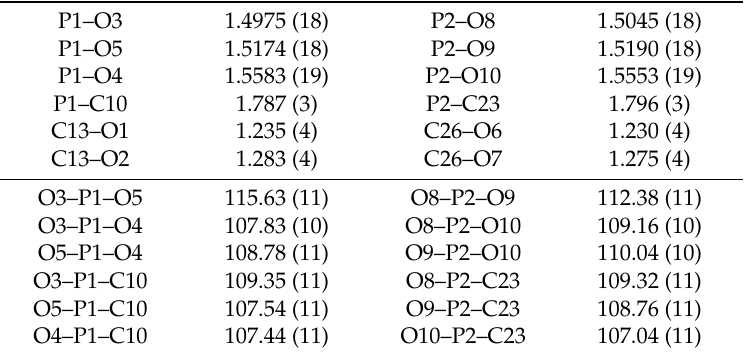
Table 2. Selected bond lengths [Å] and angles [ ˝ ] in 1